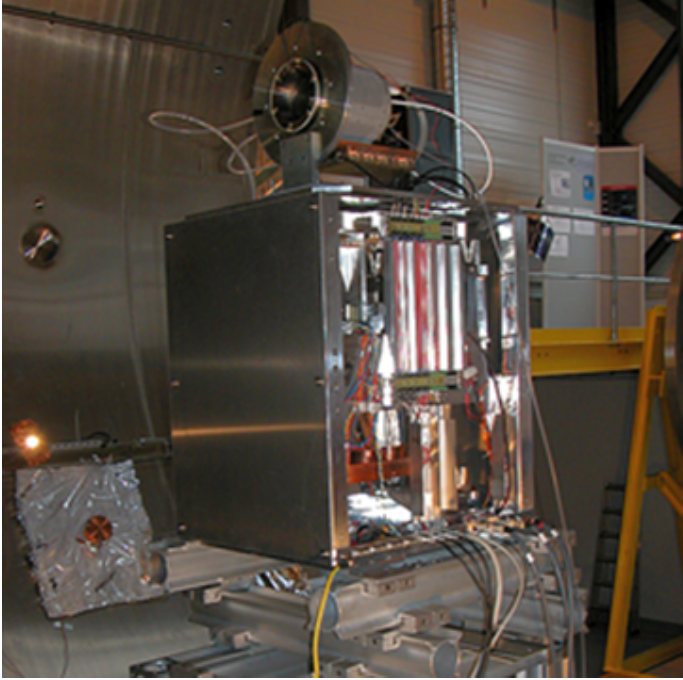
Figure 3: Thrust balance with open lid on one side. A gridded ion thruster is mounted on the